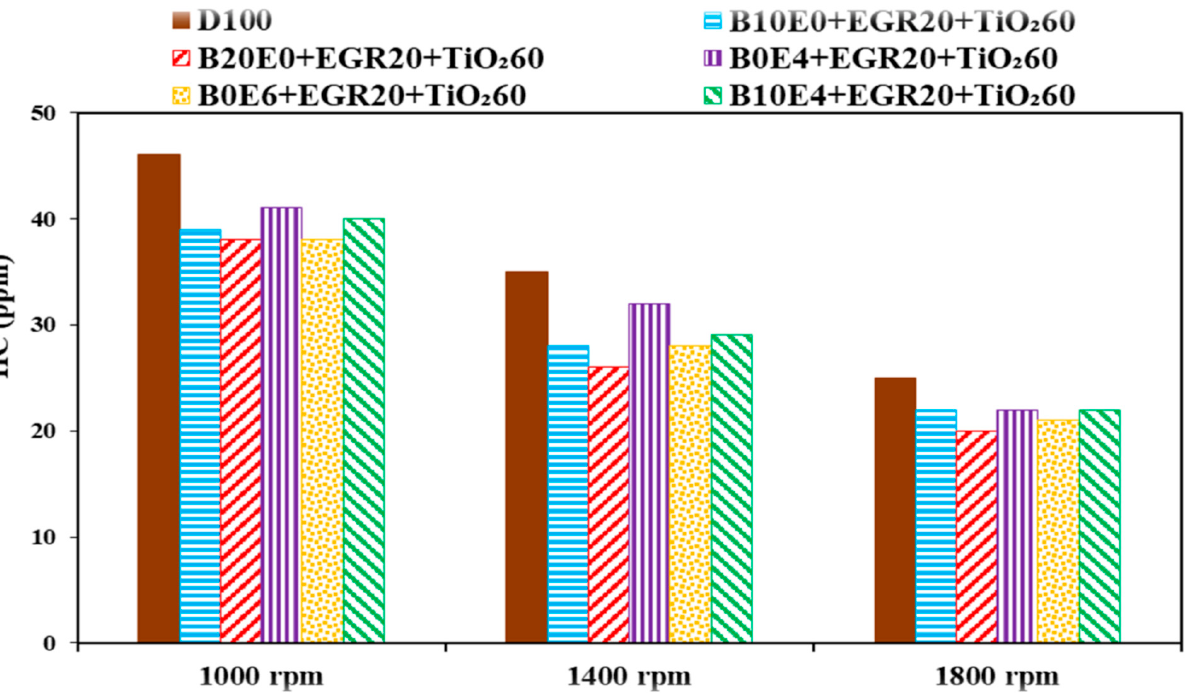
Figure 16. Variation of HC for diesel/ethanol/biodiesel blends at EGR = 20%, TiO 2 = 60 ppm, and various engine speeds.